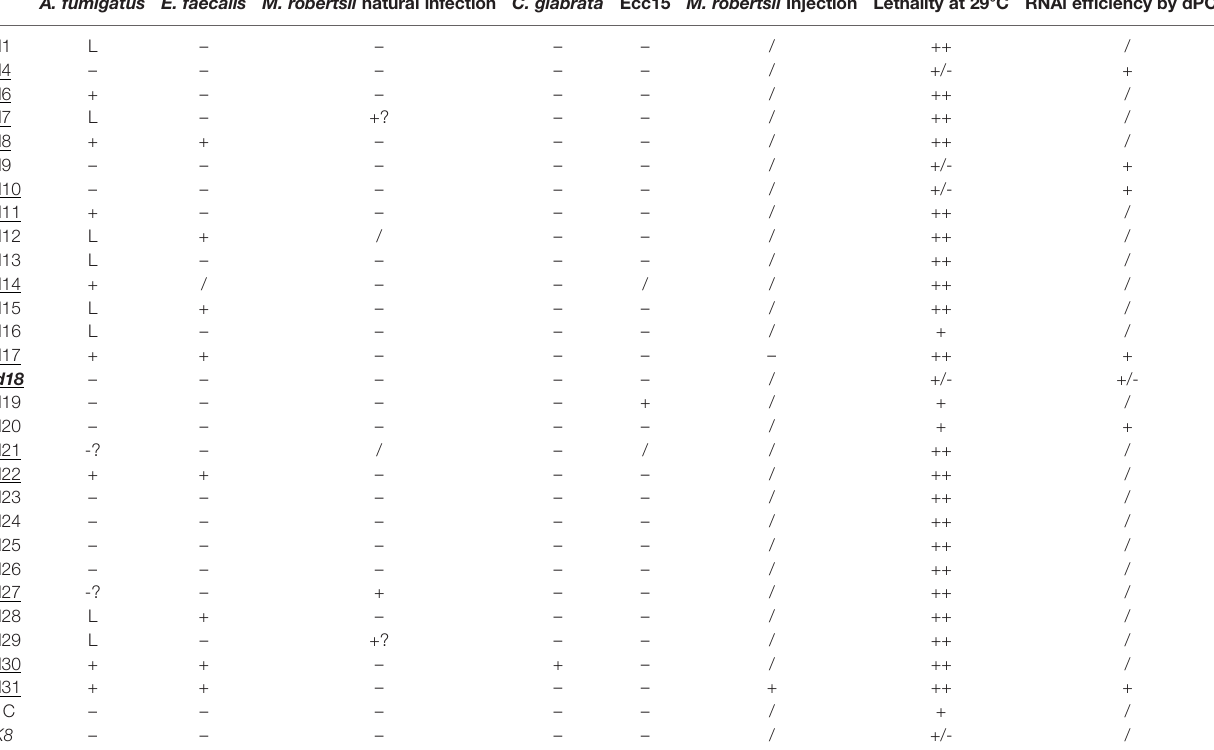
TABLE 4 | Summary of Med subunits in host defense against pathogens.